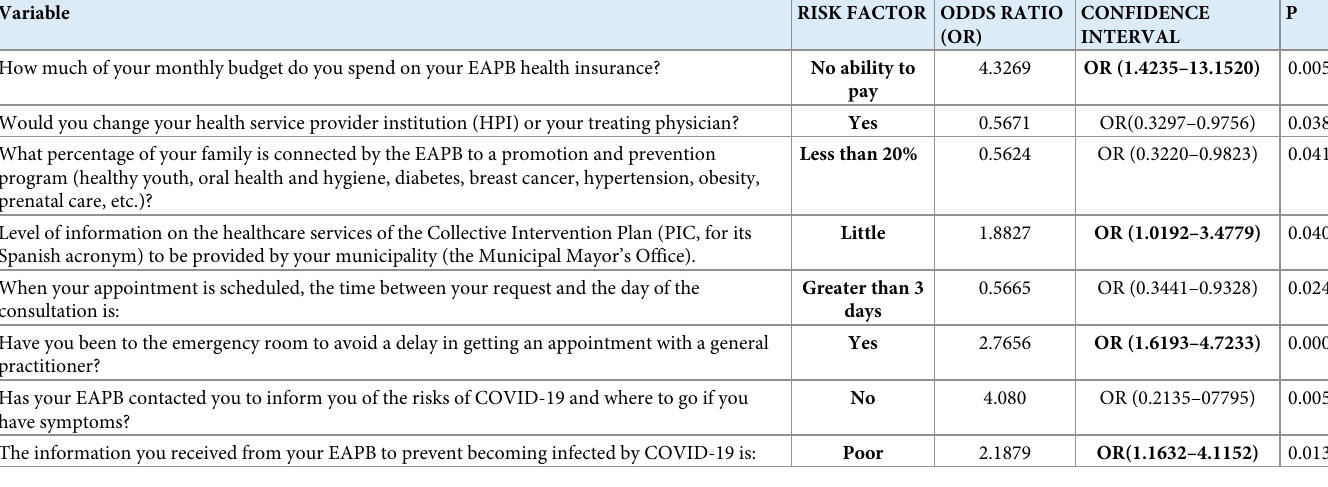
Table 3. Bivariate